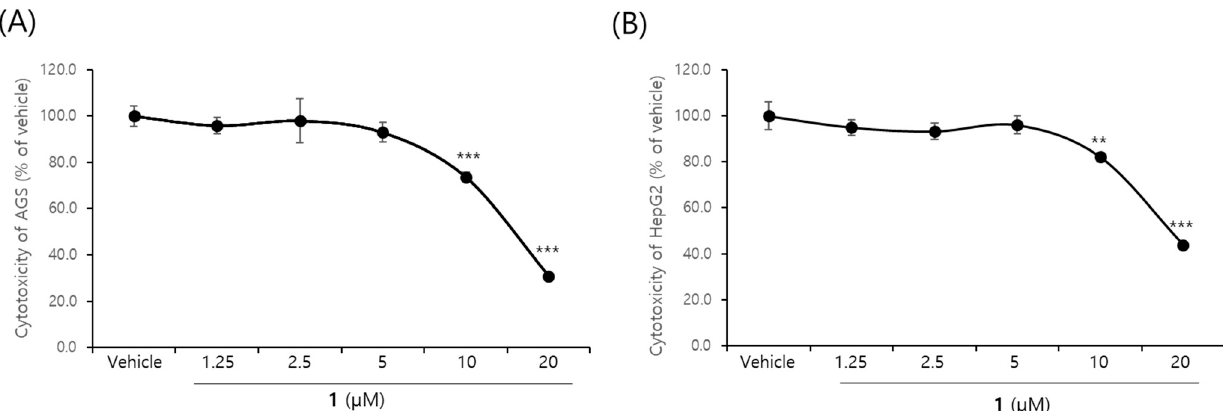
Figure 5. Dose–response curves of 1 on AGS ( A ) and HepG2 ( B ) carcinoma cell lines. Cells were cultured with 0–20 μ M of 1 for 24 h. Each value is expressed as the means ± SD of triplicate determinations. ** p < 0.01, *** p < 0.001 versus vehicle group.